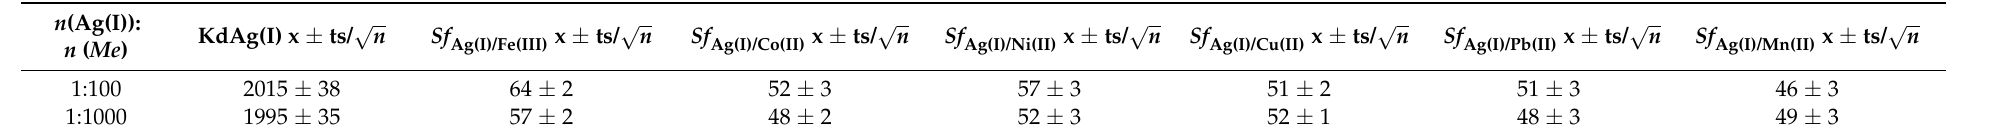
Table 3. Separation factor ( Sf ) obtained between Ag(I) and Fe(III), Co(II), Ni(II), Cu(II), Pb(II), and Mn(II) (concentration of nitric acid 0.1 M) at 298 K, in dynamic conditions (n = 3, p =